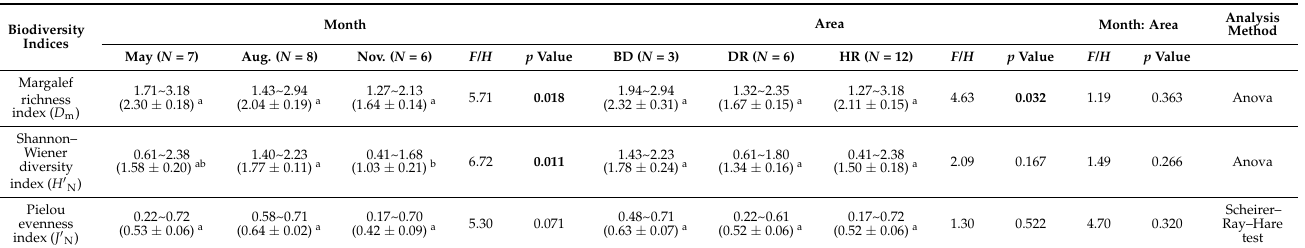
Figure 4. Zooplankton ( a ) abundance and ( b ) biomass among different sampling months and areas in DJKR. Mean values (left y -axis) of zooplankton are represented by the grey histogram. Values (right y -axis) for each group (Protozoa, Rotifera, Copepoda, Cladocera) are represented by boxplots with original data points, and different letter labels indicate a significant difference ( p < 0.05) between the months or the areas. To decrease the effects of the existing maximum value and improve the visual appearance, the right y -axes of the graphs are shown with ln(x + 1)-transformed scales. HR: Hanjiang reservoir area, DR: Danjiang reservoir area, BD: the area close to the dam. Table 1. Changes in the zooplankton biodiversity indices among different sampling months and areas in